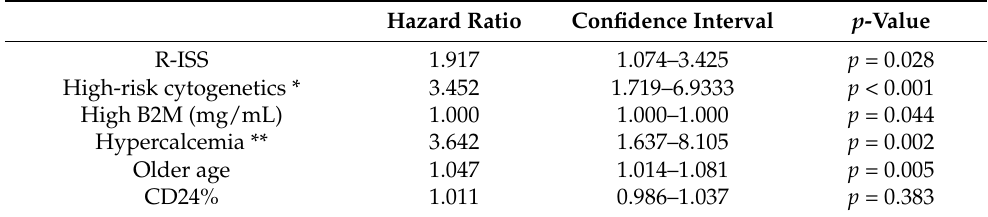
Table 6. Multivariate analysis showing the statistically significant factors correlating with poorer OS and